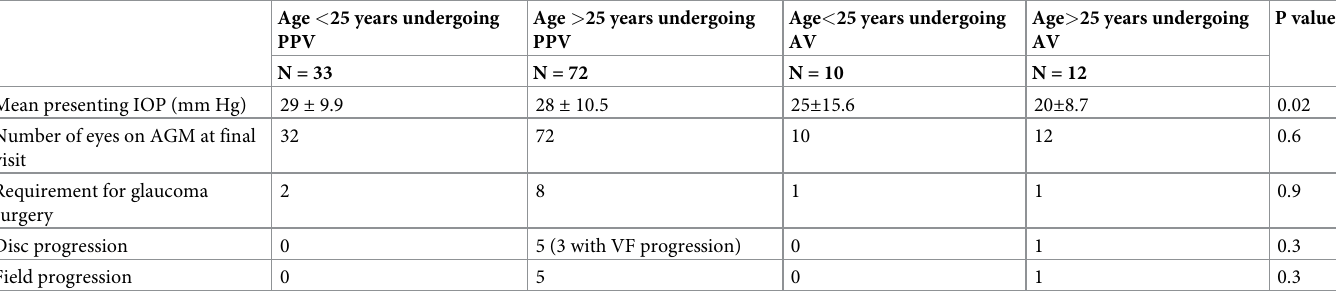
Table 3. Comparison of age-wise distribution of central corneal thickness in the affected eye and control eye after pars plana vitrectomy or anterior vitrectomy. Age < 25 years undergoing